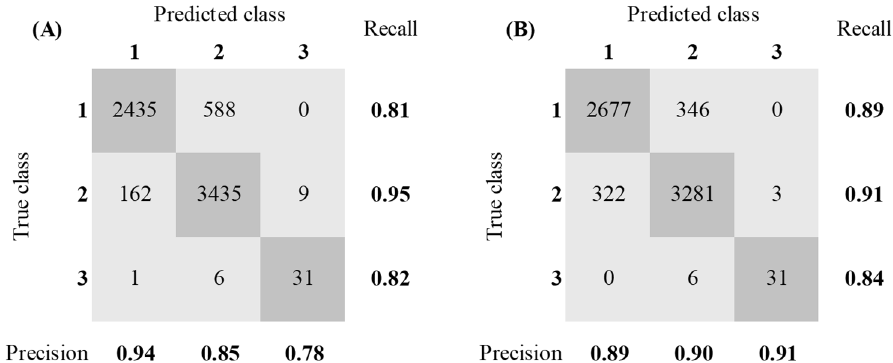
Figure 5. Confusion matrices of the Random Forest model ( A ) and the Bagged Trees model ( B ). (Class 1 = static behavior, class 2 = semi-dynamic behavior, class 3 = high-dynamic behavior).